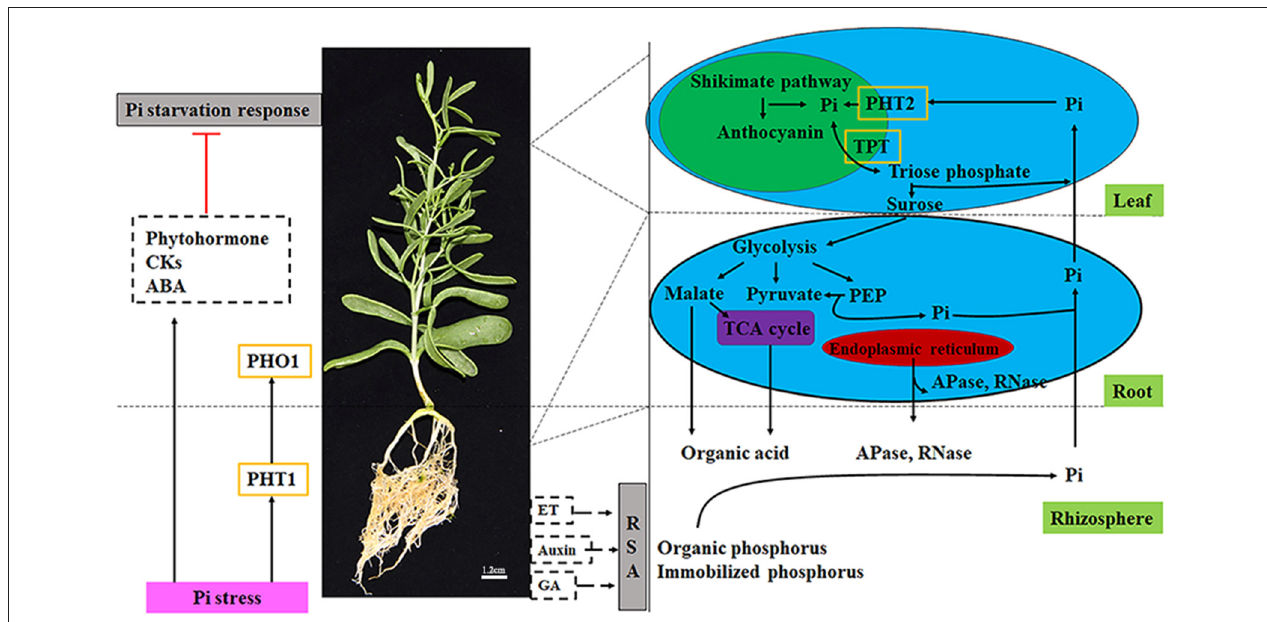
FIGURE 9 | Illustration of key components involved in the Pi stress metabolic pathway in Zygophyllum xanthoxylum . Black solid arrows and red terminated lines represent positive regulation and suppressed expression, respectively. Dotted black arrows indicate no-effect. Gray boxes represent responses of Pi deficiency. Pink boxes show the condition of the external environment. Dotted boxes represent plant hormones. Words with green backgrounds express plant and rhizosphere tissues. Blue ovals show the cells in the roots and leaves. Within cells, green ovals represent the chloroplast. Purple ovals represent the mitochondria. Red ovals represent the endoplasmic reticulum. Yellow boxes represent transporters. CK, cytokinins; GA, gibberellin; ABA, abscisic acid; ET, ethylene; RSA, root system architecture; Pi, inorganic phosphorus; PEP, phosphoenolpyruvate; TCA cycle, tricarboxylic acid cycle. Redrawn from Ren et al. (2018).